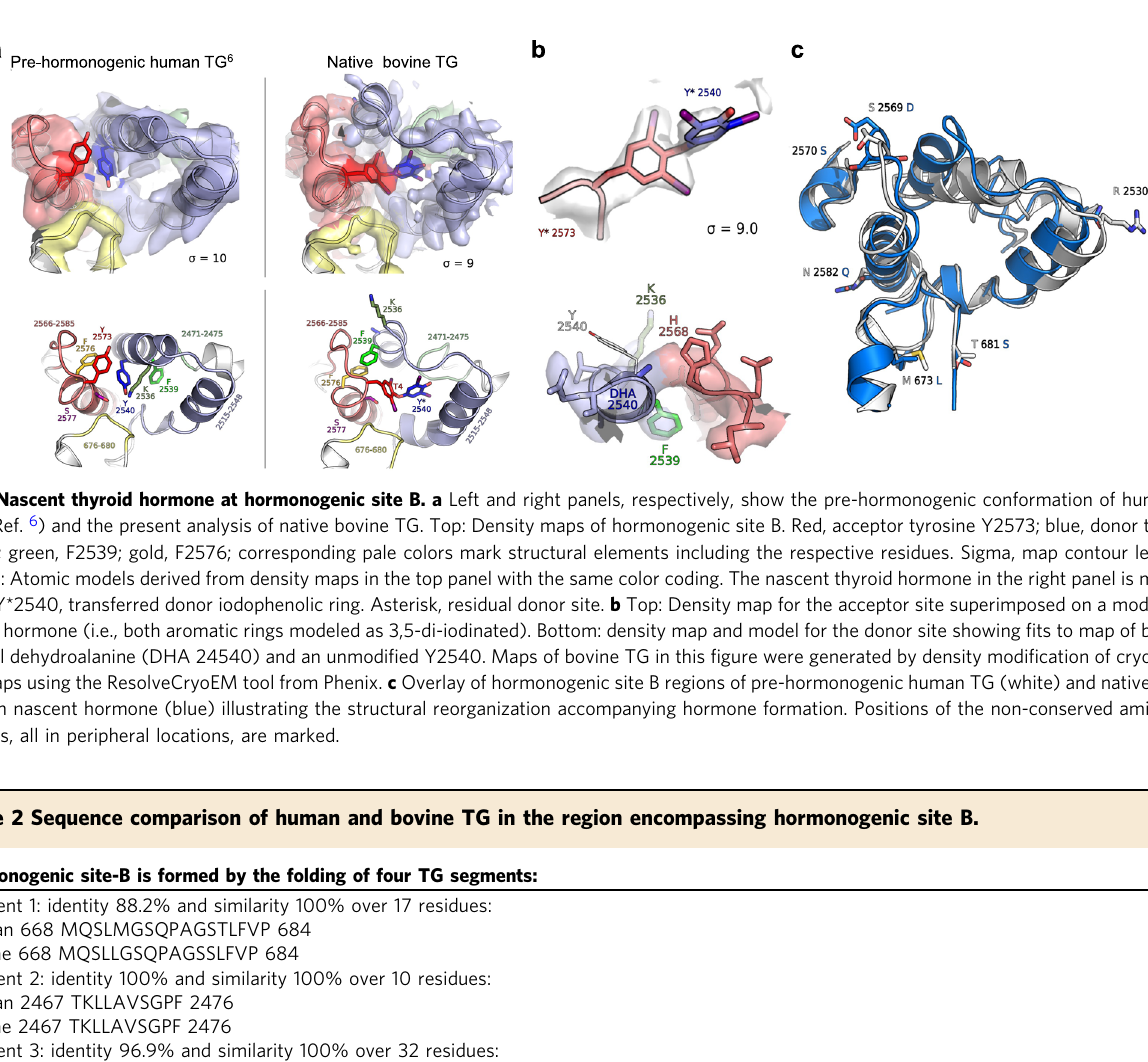
Table 2 Sequence comparison of human and bovine TG in the region encompassing hormonogenic site B. Hormonogenic site-B is formed by the folding of four TG segments: Segment 1: identity 88.2% and similarity 100% over 17 residues: human 668 MQSLMGSQPAGSTLFVP 684